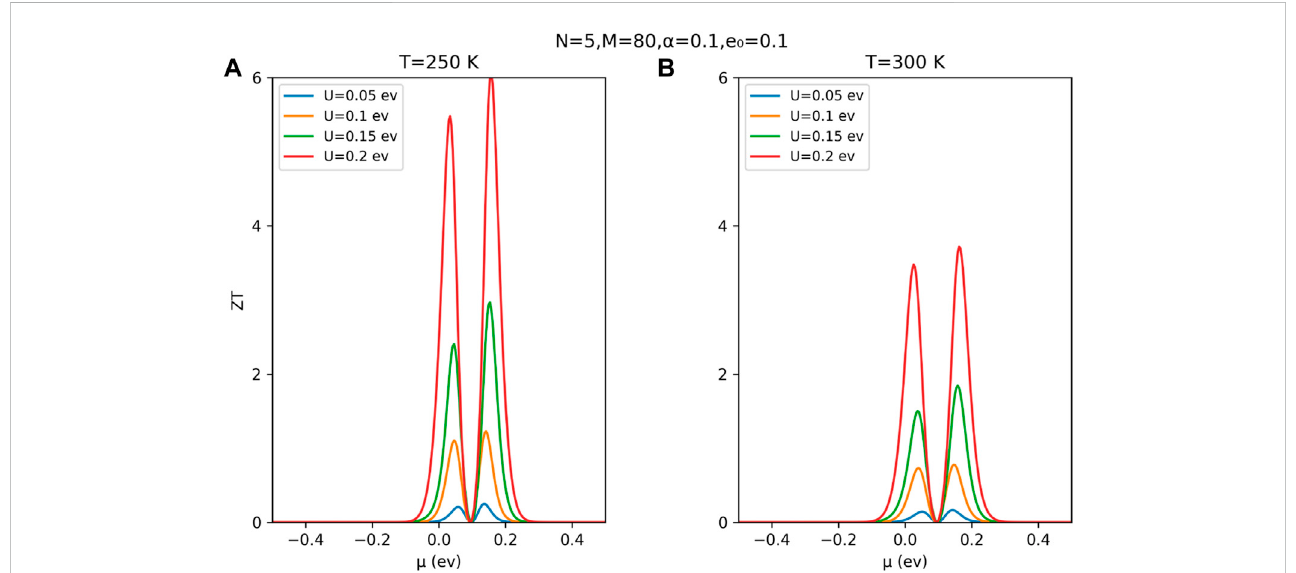
FIGURE 6 Electronic fi gureofmeritasafunctionofthechemicalpotential,foranA-SNRofwidth N =5andlength L =80.Wehaveplottedpanels (A) and (B) fortwo different temperatures, increasing the external potential